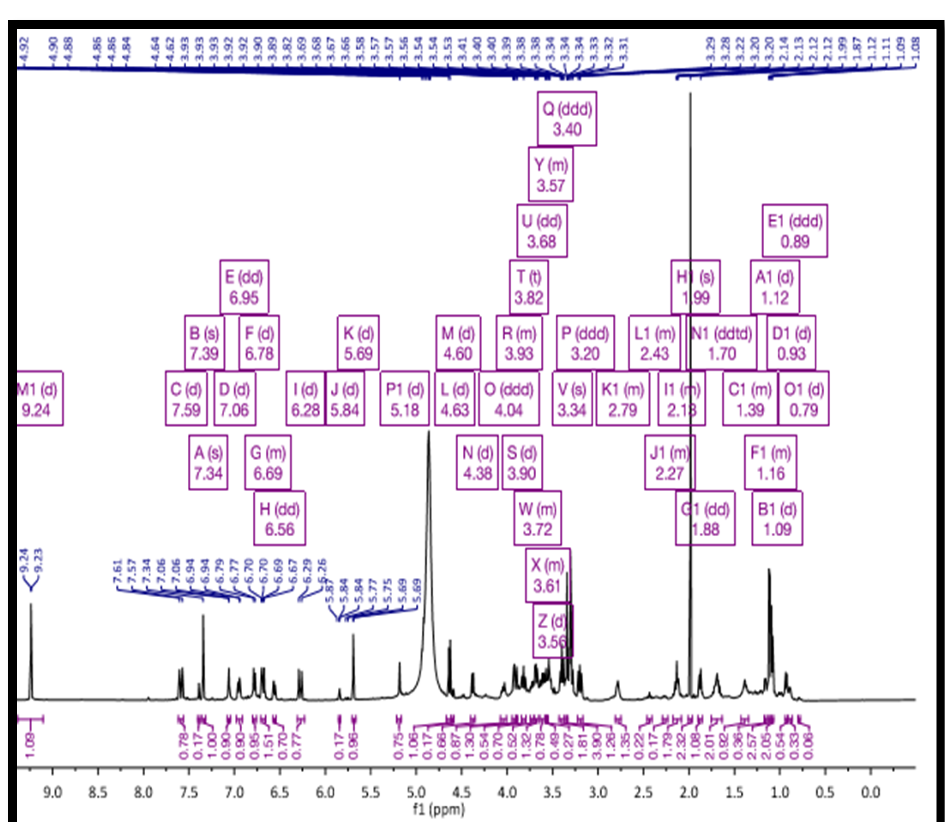
Figure 4. Nuclear magnetic resonance (NMR) for the isolated component A-3.